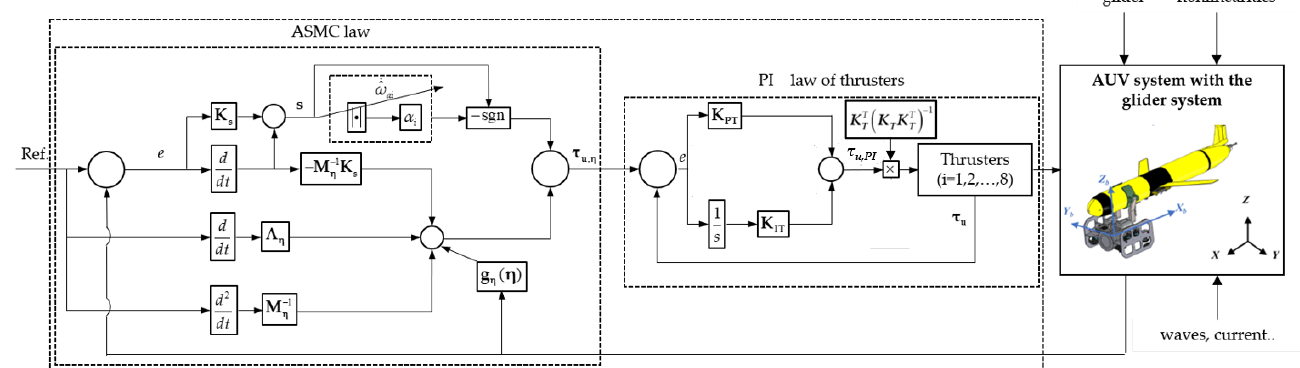
Figure 6. The proposed cascade ASMC-PI control law for the ROV retrieving the underwater glider.